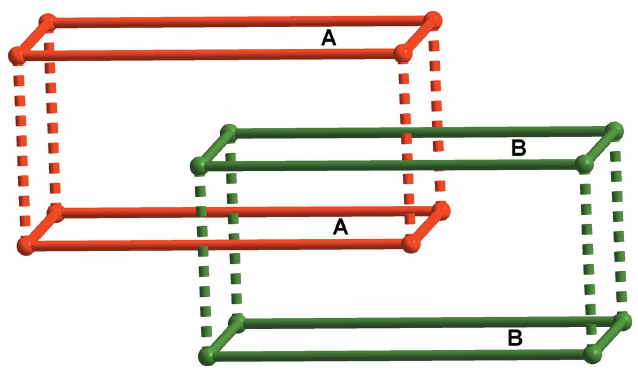
Figure 5 The twofold interpenetrated supramolecular framework with a pcu topology network connected by C—H (cid:2)(cid:2)(cid:2) Cl hydrogen bonds (shown as dashed lines).